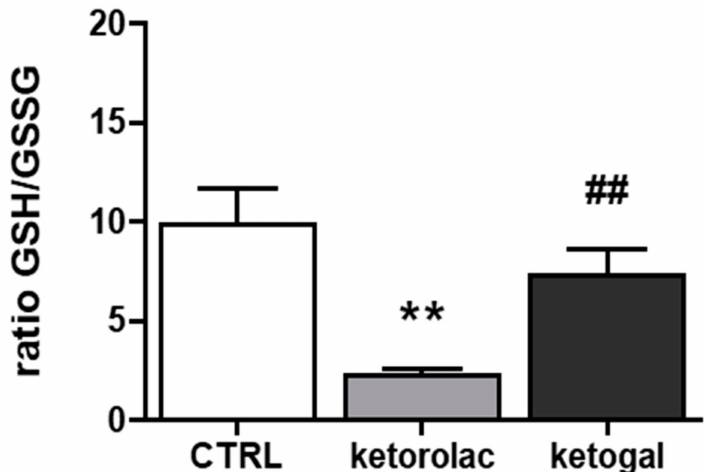
Figure 5. Glutathione measurement. GSH and GSSG were measured spectrophotometrically in triplicate in the cell lysates and expressed as nmol of glutathione/min/mg cellular protein. Data are presented as means ± SEM ( n = 3) of GSH/GSSG ratio. Significance of treated (ketorolac or ketogal) versus respective untreated cells: ** p < 0.01. Significance of ketogal vs. ketorolac: ## p <